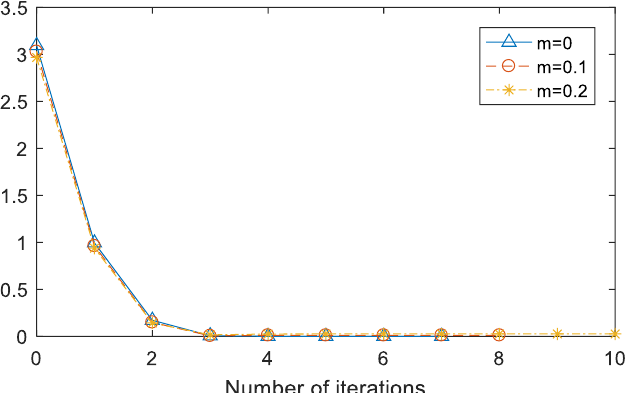
Figure 4. Convergence of K s